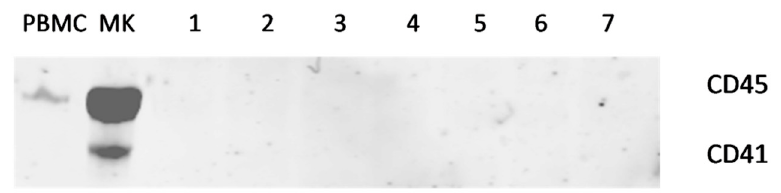
Figure 1. Representative Western blot of ITGA2b (CD41) and PTPRC (CD45) proteins observed in control samples (peripheral blood mononuclear cells (PBMC) and megakaryocytes (MK)) and in seven plasma samples randomly chosen to show the absence of residual cells in the plasma samples.